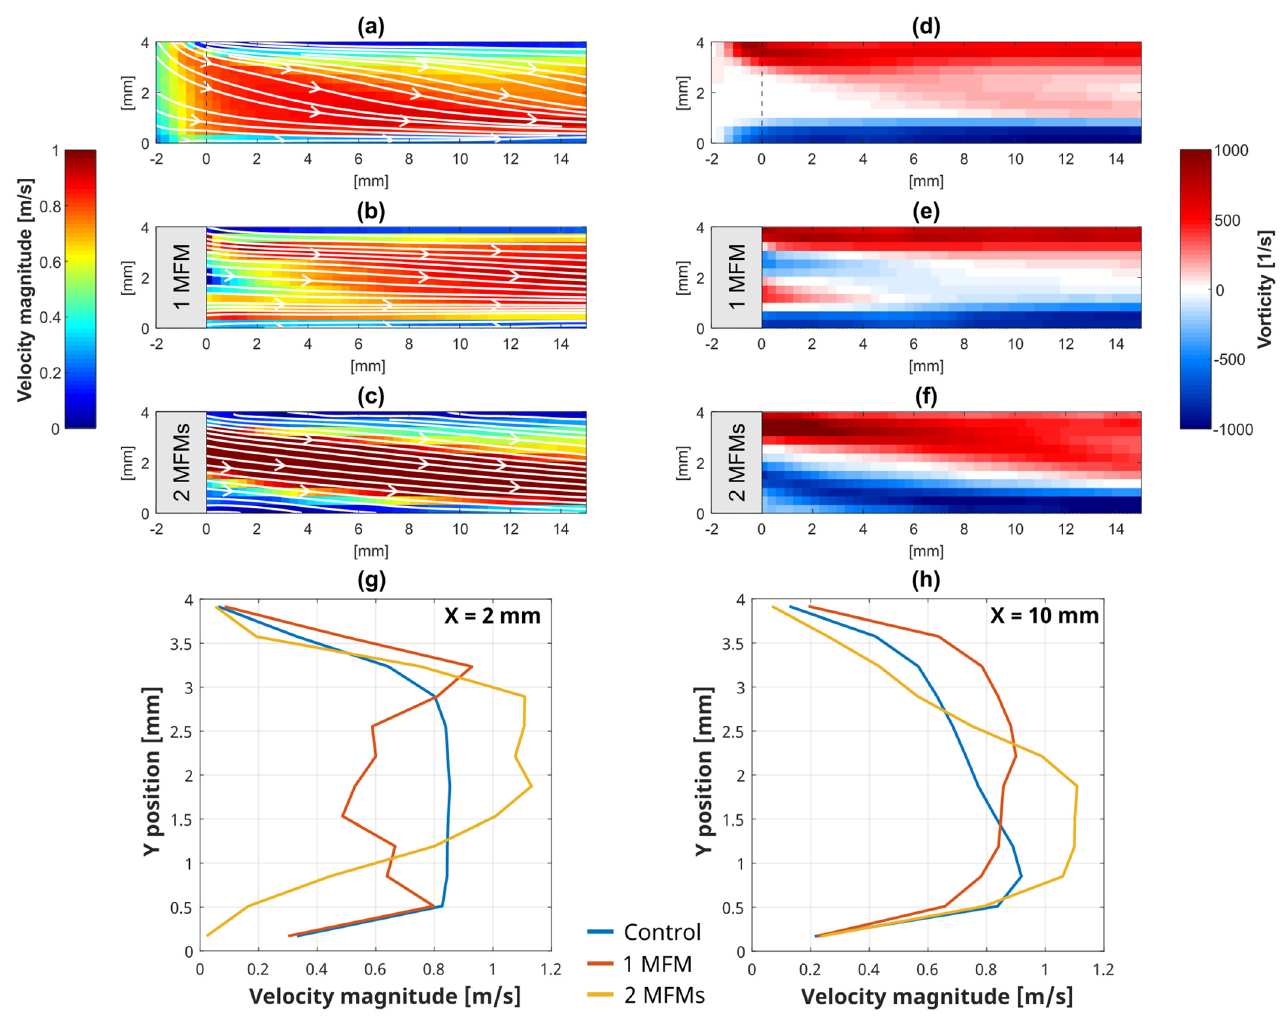
Figure 5. Local flow analysis. Velocity magnitude ( a – c ) and vorticity ( d – f ) maps evaluated by PIV in the LRA of ( a , d ) control, ( b , e ) single and ( c , f ) overlapped cases. ( g , h ) Velocity magnitude profile extracted 2 and 10 mm away from the bifurcation, respectively.